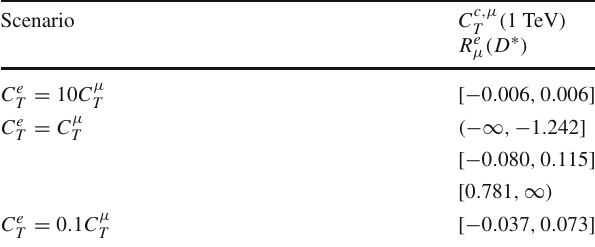
compatible with the B ( B c → τ ¯ ν τ ) P